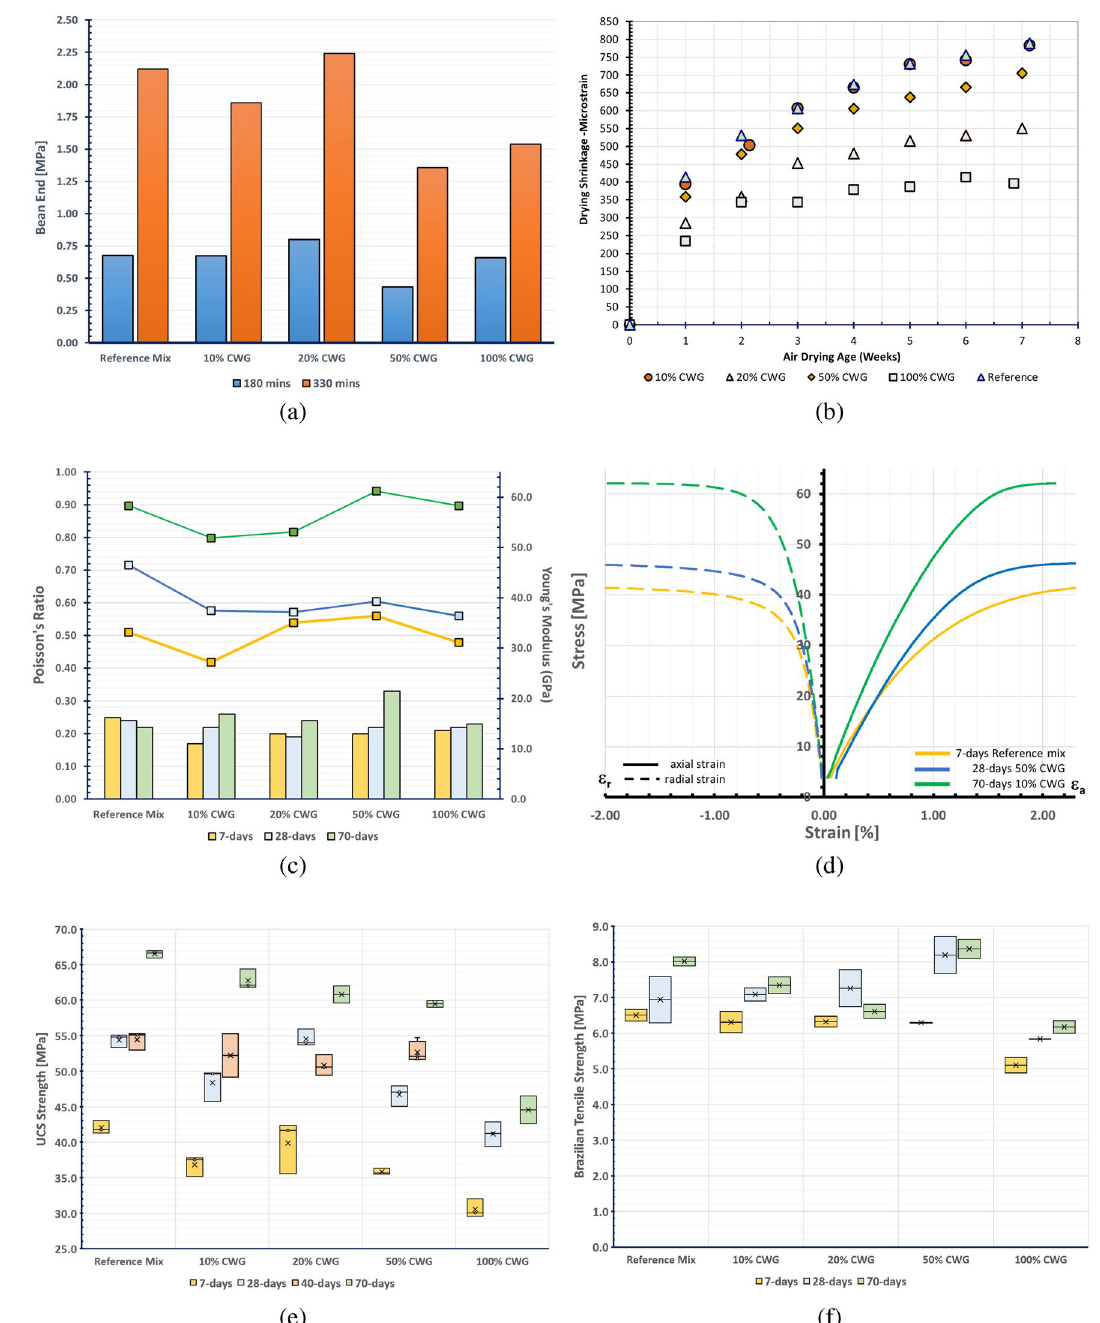
Fig. 4 Influence of sand replacement with glass aggregates on shotcrete properties, including its a early-age strength, b drying shrinkage, c elastic properties, d stress–strain behaviour, e unconfined compressive strength, and f tensile